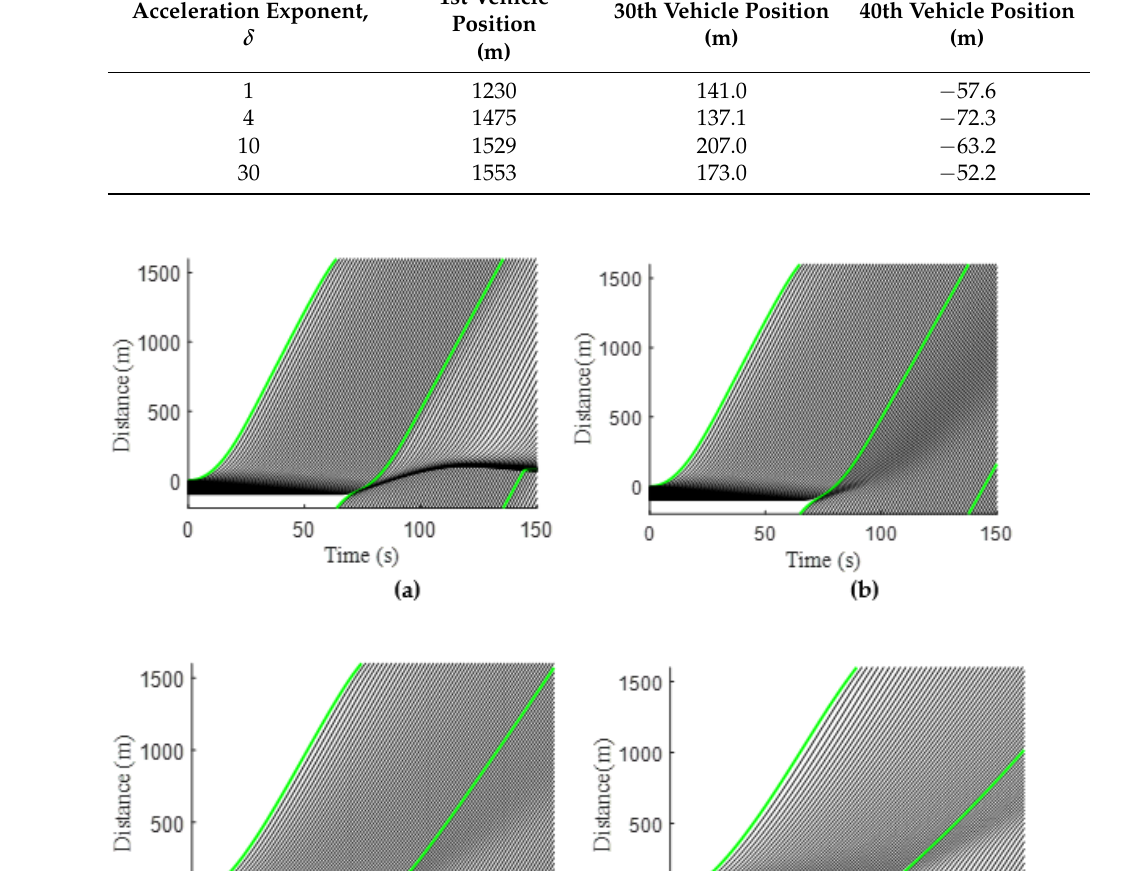
m circular road: ( a ) m. The colored line 1800